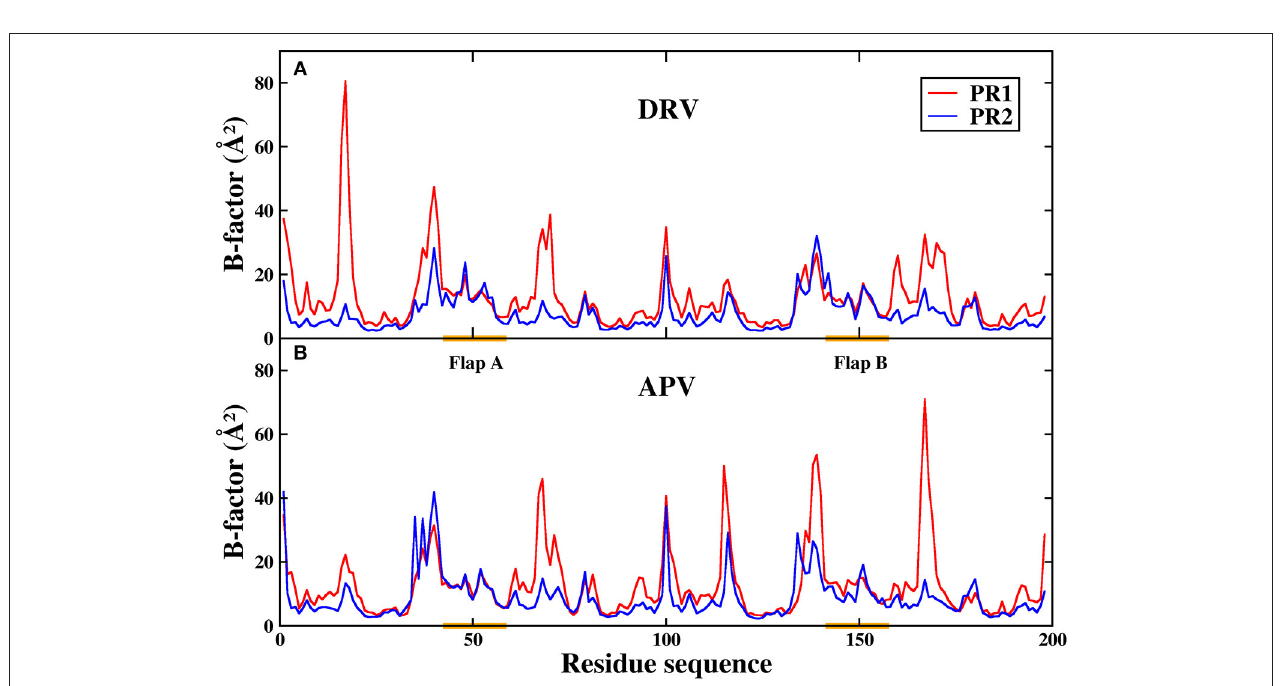
combined with PR1 and PR2, the difference of entropy change is 6.19 kcal/mol. For APV inhibitor, the differences are